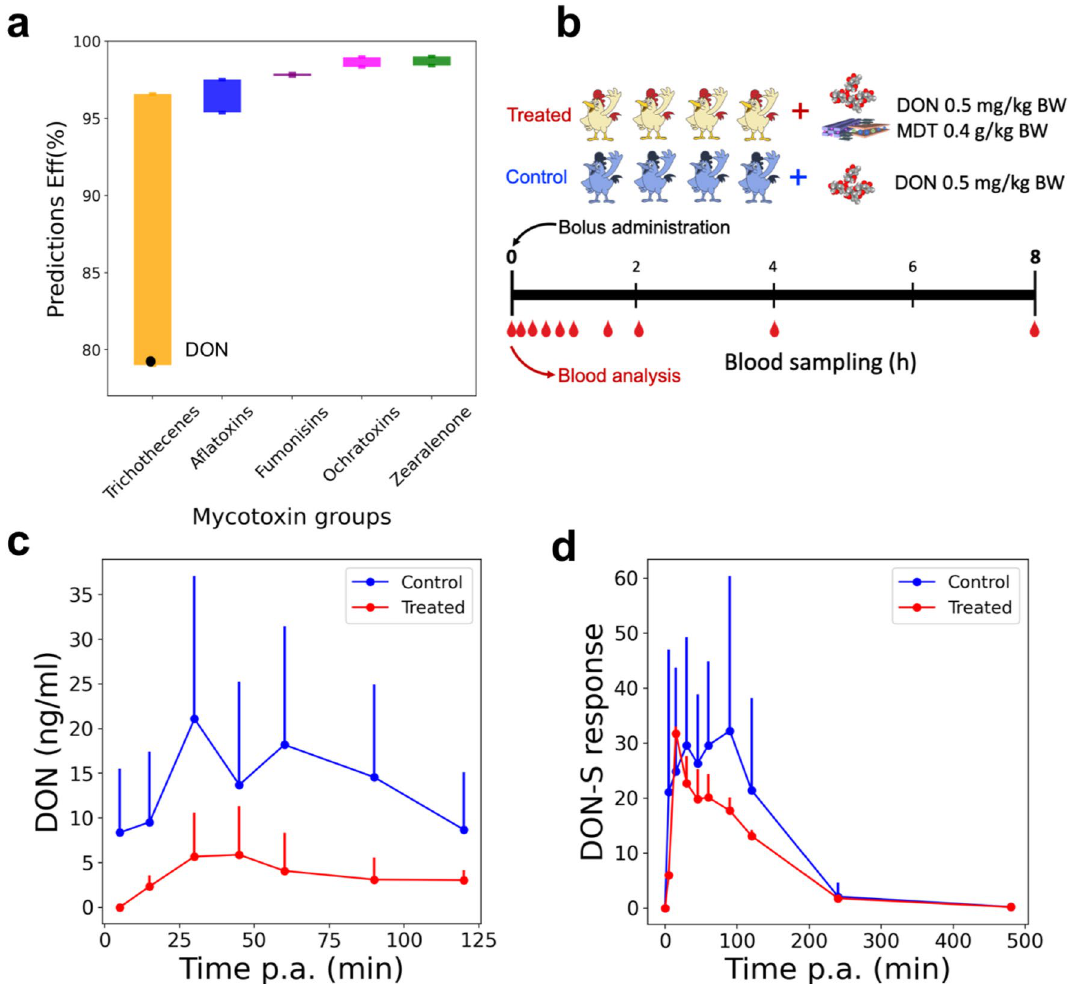
Figure 5. Response of predicted in vitro efficiency of SEP/MONT/AC towards the removal of the explored mycotoxin groups ( a ). The predictions were obtained by RF fixing the experimental setting to 2 kg/t of inclusion rate of SEP/MONT/AC, 2 µg/ml of toxin concentration, adsorption and desorption pH to 3 and 6.5, respectively. Graphical representation of in vivo design of experiment validating the detoxification of DON by SEP/MONT/AC detoxifier ( b ). Mean plasma concentration and standard deviation of DON after single oral bolus administration of DON alone (0.5 mg/kg BW) and DON in combination with SEP/MONT/AC (0.4 g/ kg BW) to 8 broiler chickens ( c ). Mean response and standard deviation of deoxynivalenol-sulphate (DON-S) in plasma after single oral bolus administration of DON alone (0.5 mg/kg BW) and DON in combination with SEP/MONT/AC (0.4 g/kg BW) to 8 broiler chickens ( d